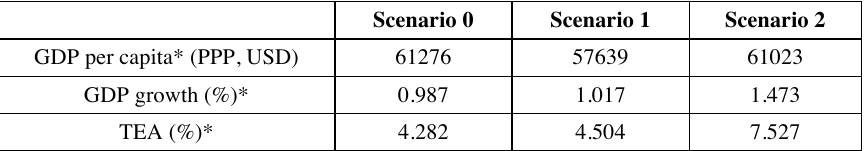
Table 6 Simulation results